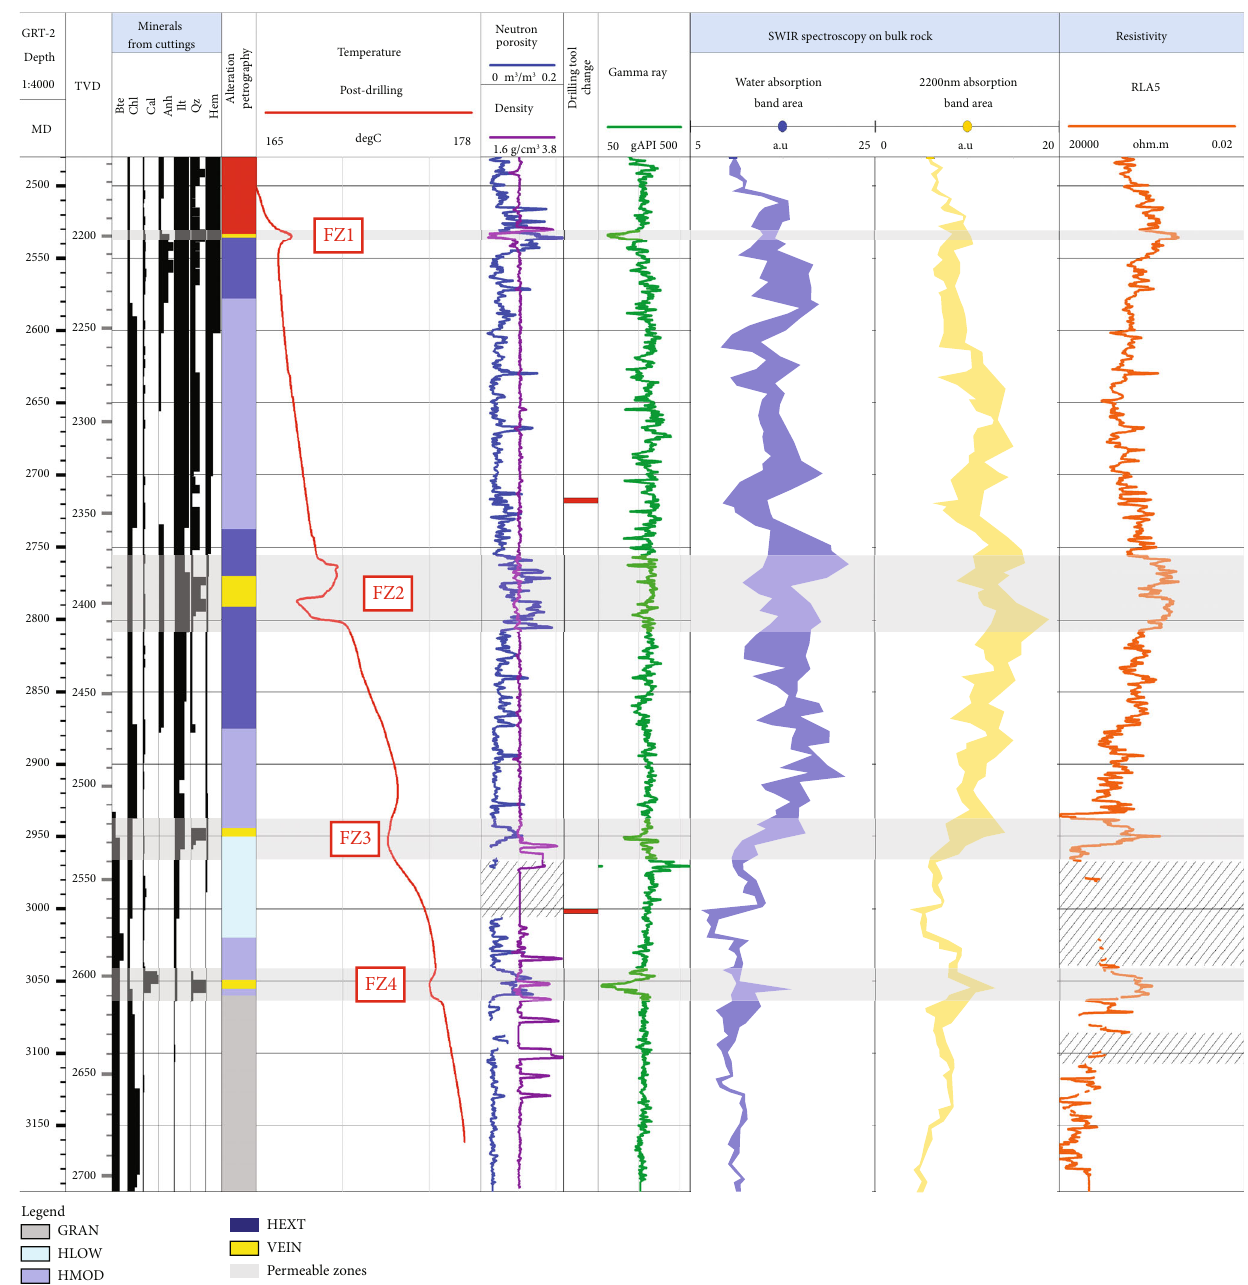
Figure 5: Composite log of the GRT-2 well at Rittersho ff en presenting the mineral quantity, petrographical log, T log, porosity and density logs, drilling tool change, total GR, SWIR results with water and the 2200 nm absorption band areas, and resistivity log. Petrographical facies abbreviations are de fi ned in the legend in Figure